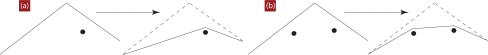
Central routine of the Z1 code finds the shortest path for two adjacent segments (solid lines) in the presence of none, one (a), two (b), or more obstacles. Each obstacle correspond a point which belongs to the contour of a different chain (not shown), and which intersects with the plane spanned by the two segments. Z1 locates potentially intersecting points efficiently, and operates at a variable number of nodes characterizing the shortest path. The central routine is iteratively applied to all pairs of adjacent segments until the multiple disconnected path has converged to a minimum length. The algorithm scales linearly with the total number of particles.